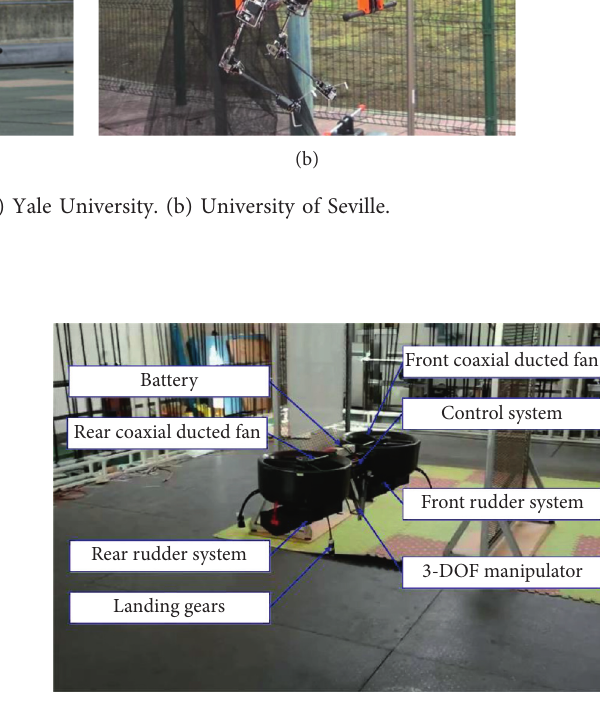
Figure 3: The configuration of the novel aerial manipulator.